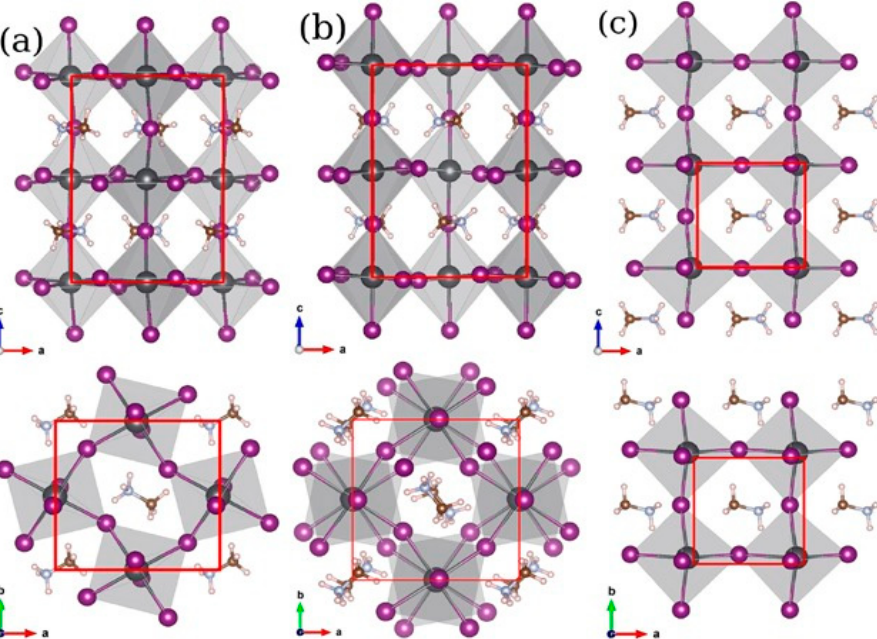
Figure 4. Different phases of perovskite (MAPbI 3 ): ( a ) orthorhombic, ( b ) tetragonal, and ( c ) cubic. Top row: ( a – c ) plane and bottom row: a-b plane (Reproduced from [27]).